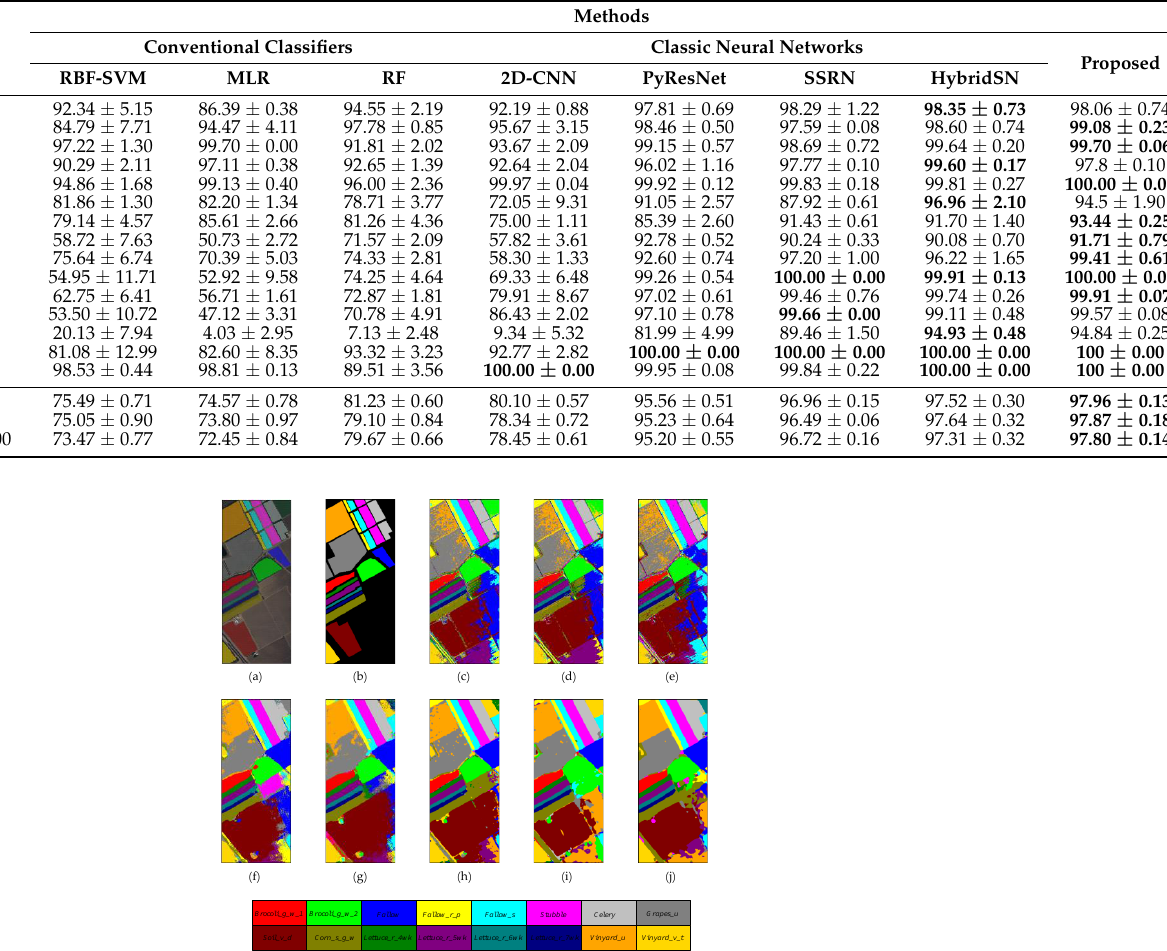
Table 8. The categorized results of different methods on the Grass_dfc_2013 dataset.